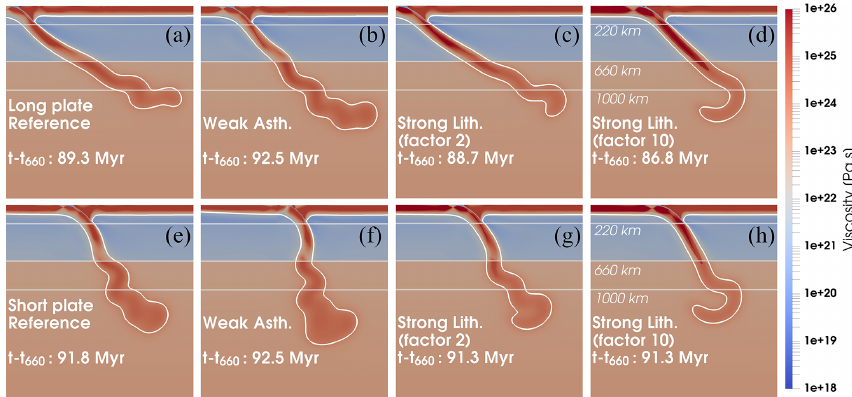
Figure 5. Comparison of final slab shapes for different models shown as a snapshot of the viscosity field. Long-plate (top row, a–d ) and short-plate (bottom row, e–h ) cases of reference models (a, e) , weak asthenosphere models (b, f) , and strong lithosphere models with strength scaling factors of 2 (c, g) and 10 (d, h) . White contour marks the 1100 ◦ C isotherm as the outline of the lithosphere. The vertical and horizontal spatial scales are identical, with grey lines to mark depths of 220, 660 and 1000km. For every type of model, the subducting slab in the short-plate model has more buckles and has undergone less trench retreat than in the long-plate